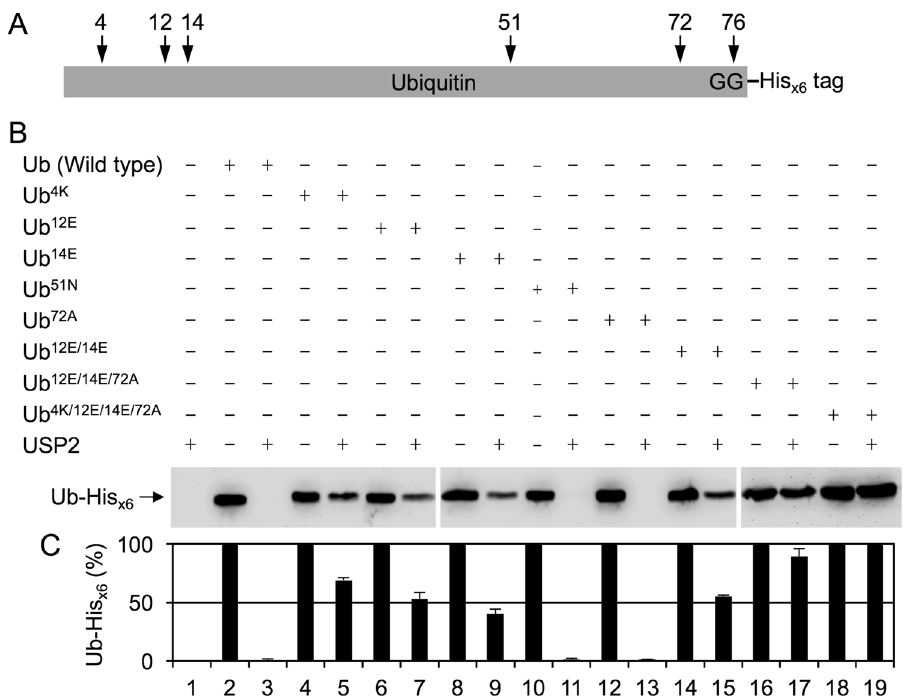
Figure 2. Residues at positions 4, 12, 14, and 72 of Ub are the molecular determinants for specific binding and catalysis by USP2. ( A ) A schematic diagram of the primary structure of the recombinant Ub used in the study, whose C-terminal di-glycine motif was fused with a His x6 tag (noted as Ub-His x6 ). USP2 cleaves on the normal peptide bond between the di-glycine motif (noted as GG) of Ub and the His x6 tag. The key residues of Ub interacting with USP2 were also labeled and marked with arrows. ( B ) Wild-type Ub-His x6 and indicated mutants (9.2 μ M) were incubated with or without USP2 (4.75 μ M) at 37 °C for 60 min. All reactions were terminated by adding 4X SDS-PAGE sample buffer and incubating at 100 °C for 10 min. Samples were separated on 16.6% SDS-PAGE and further analyzed using western blotting with the anti-His x6 tag antibody. Data are representative of three independent experiments. The full-length blots are presented in Supplementary Figure S1. ( C ) The signal intensity of three independent experiments was measured by a densitometer and processed by ImageJ. The results of the measurement were interpreted as a bar graph. Values are means ± S.D. from three independent experiments. The numbers noted at the bottom represent the lane numbers on the western